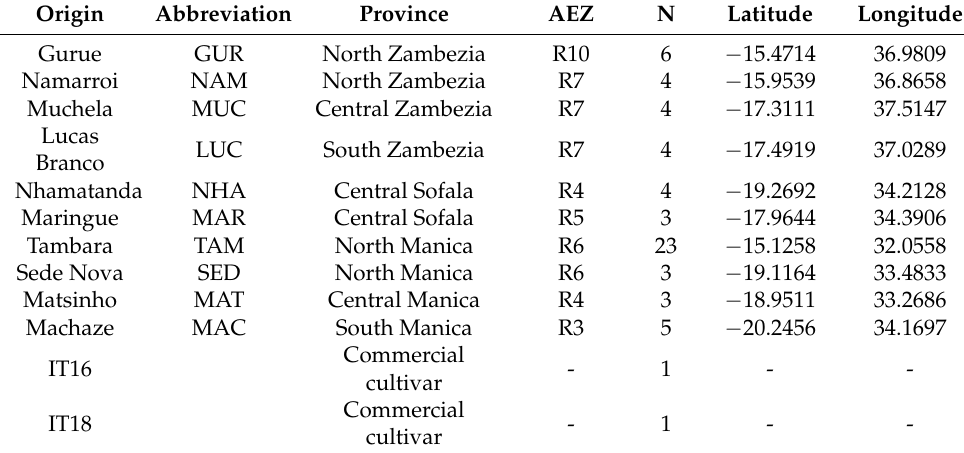
Table 1. List of the cowpea [ Vigna unguiculata (L) Walp] accessions used for the morphological study, sorted by province, agro-ecological zone, latitude, longitude, and collection sites. The two commercial cultivars—IT8 and IT16—used as controls in the study are also indicated. N indicates the number of accessions studied within each landrace. From each accession, 10 replicates were used in the morphological study totalling 610